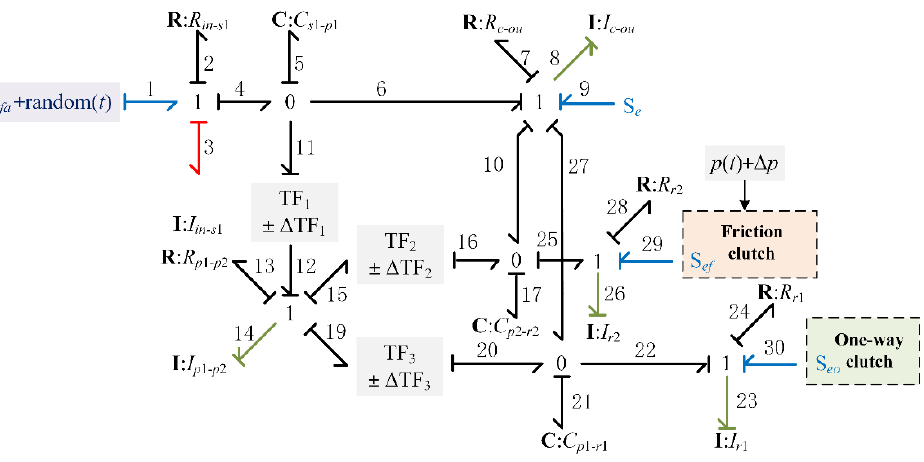
Figure 14. Double-row double planetary uncBG model.